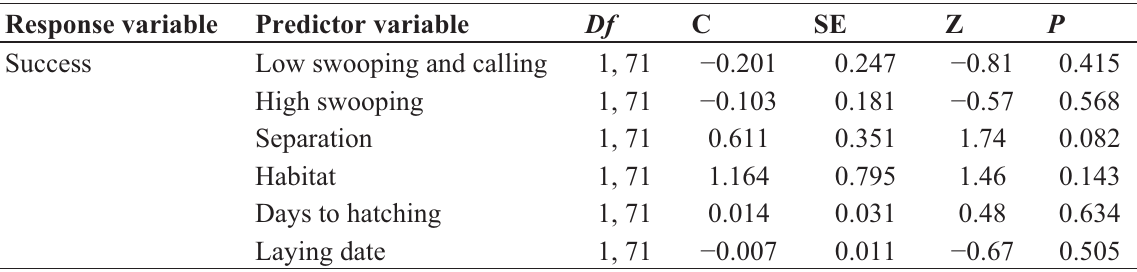
Table 4. Results from six separate binary logistic regressions investigating the influence of ‘low swooping and calling’, ‘high swooping’, ‘separation’, habitat, days to hatching and laying date on hatching success (success; 0 = failed to hatch chicks, 1 = hatched at least one chick). Df = degrees of freedom; C = coefficient; SE = standard error; Z = test statistic (n = 85